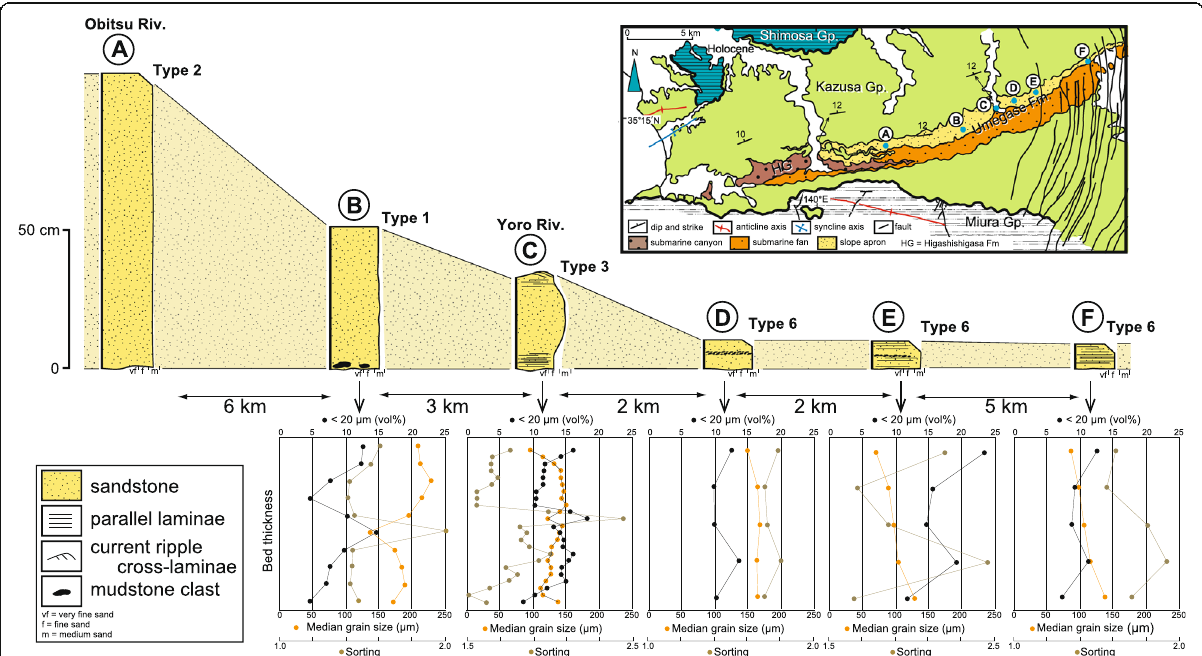
Fig. 8 Downflow changes in thickness, lithofacies types, and grain sizes of a sandstone bed developed just above the U2 tephra key bed in the Umegase Formation. The inset map shows the locations of the measured sections. Black filled circles in grain-size diagrams denote volume percentages of muddy grains less than 20 μ m. See Table 1 for descriptions and interpretations of lithofacies